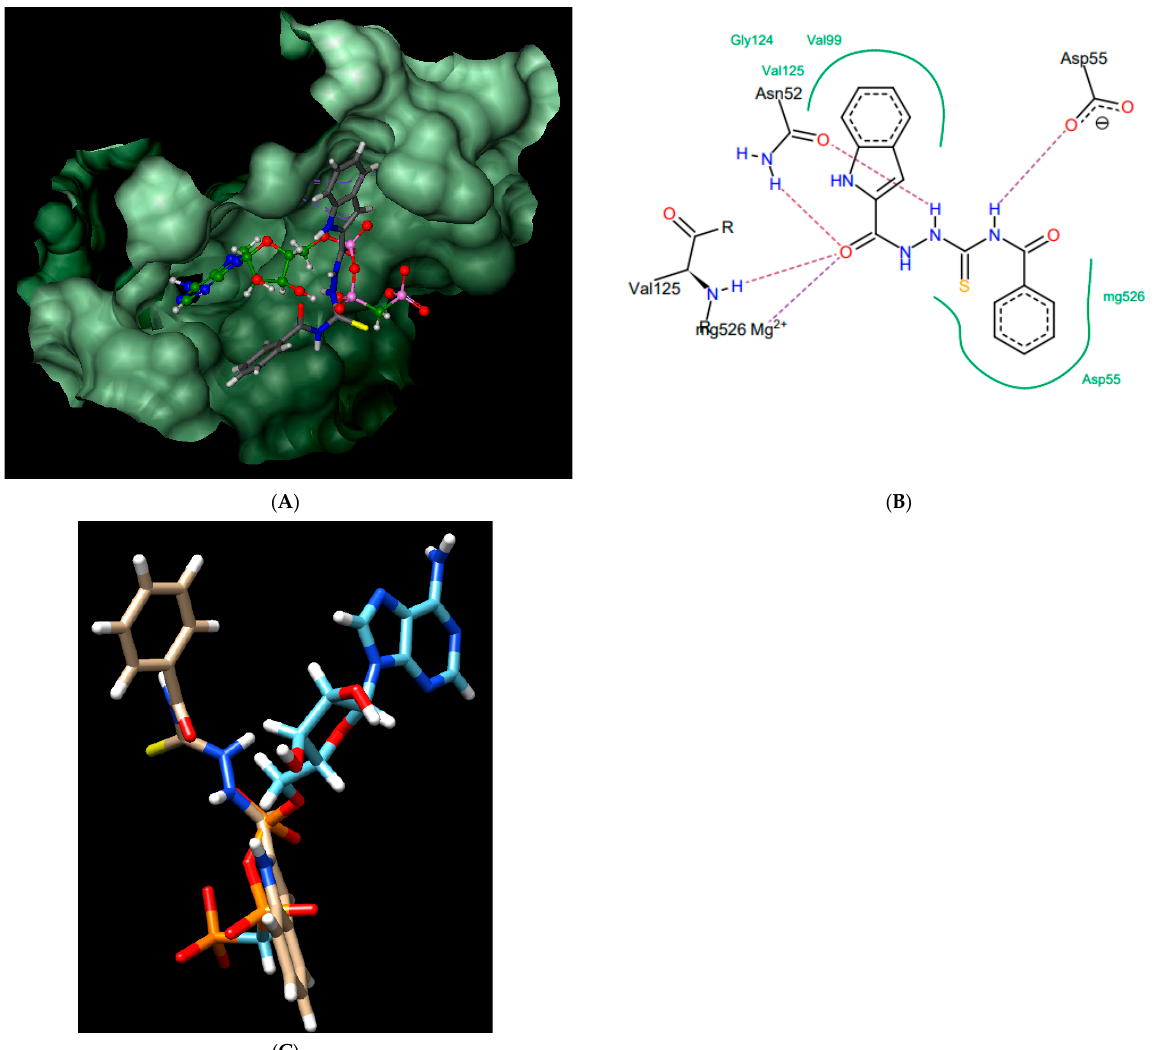
Figure 6. Compound 7 ; best pose in binding to the ATPase region of Mycobacterium tuberculosis GyrB (PDB entry: 3ZM7) ( A ), interactions with amino acids in the active site ( B ), and best pose overlaid with the native inhibitor (AMPPCP) ( C ).